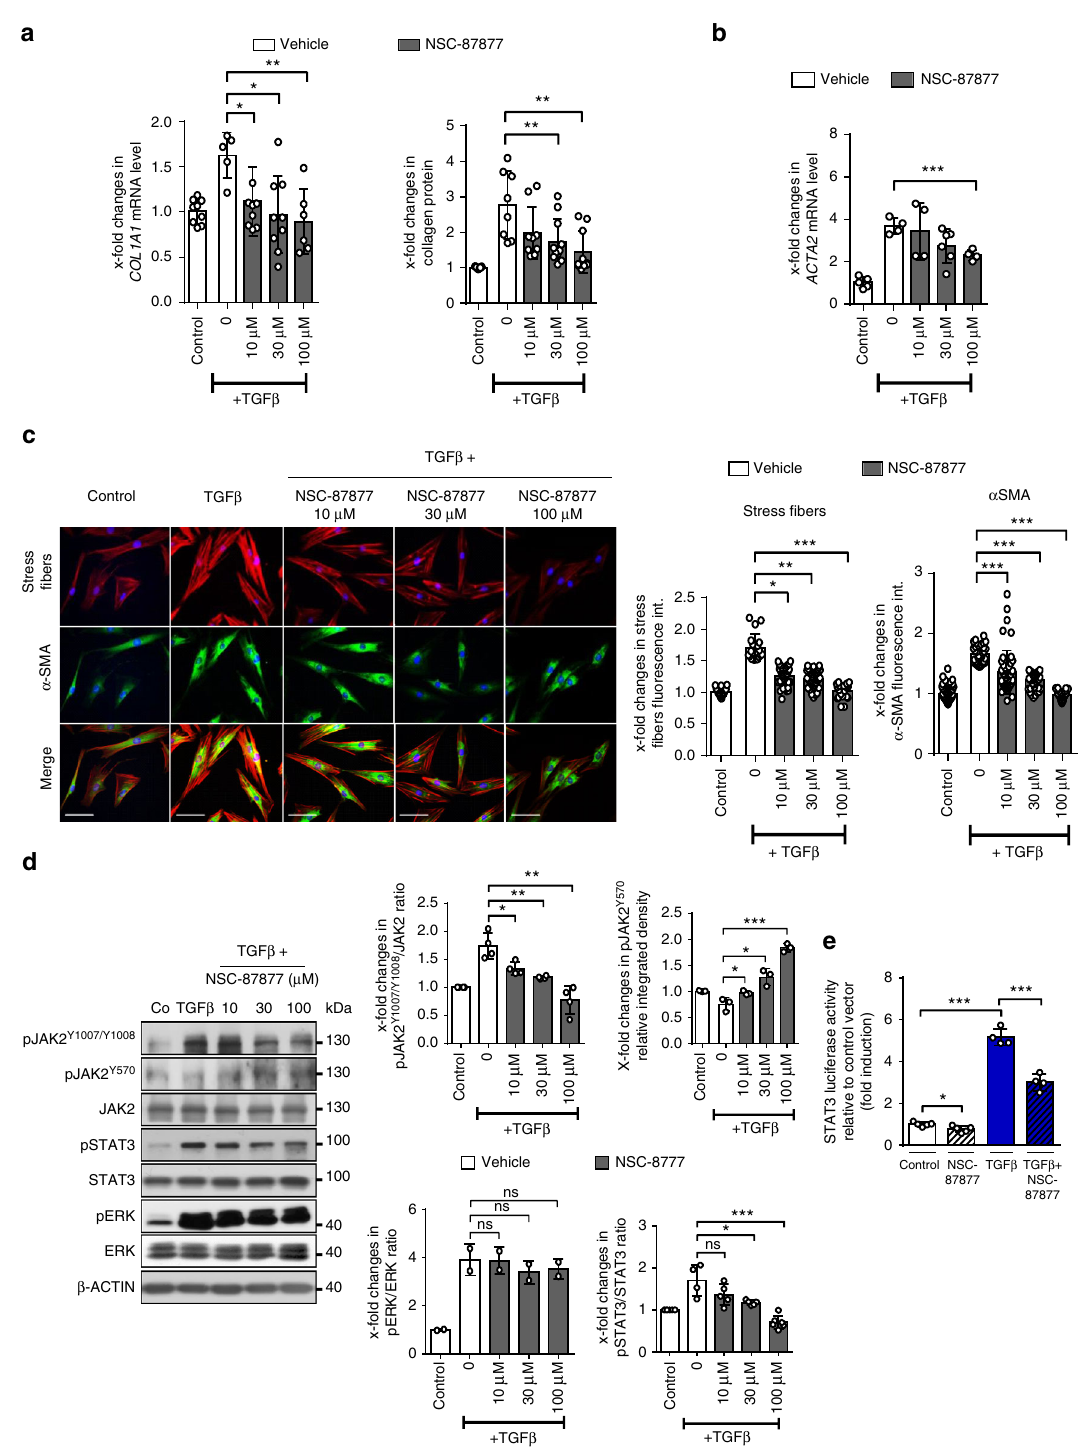
Fig. 8 Inhibition of SHP2 limits JAK2/STAT3 signaling and fi broblast activation. a Changes in the mRNA levels of COL1A1 and of collagen protein in human fi broblasts incubated with increasing doses of NSC-87877 (10 µ M, 30 µ M and 100 µ M). Fibroblasts were treated with TGF β (10 ng/ml) for 24 h. b ACTA2 mRNA. ( n ≥ 4) c Representative images of immuno fl uorescence stainings for α -SMA and stress fi ber staining are shown at 400-fold magni fi cation and quanti fi cation of α -SMA staining intensity as well as stress fi ber staining intensity ( n ≥ 15) (TGF β 10 ng/ml for 24 h). Horizontal scale bar, 500 μ m. d Representative western blots for pJAK2 Y1007/Y1008 , pJAK2 Y570 , total JAK2, pSTAT3 Y705 and total STAT3 with β -actin as loading control and quanti fi cation of the results (TGF β 10 ng/ml for 6 h) ( n ≥ 2). e Changes in STAT3 reporter activity ( n ≥ 6) (TGF β 10 ng/ml for 6 h). Results shown are representative of three independent experiments All data are presented as median ± s.e.m. The p values are expressed as follows: 0.05 > p > 0.01*; 0.01 > p > 0.001**; p < 0.001***; ns: not signi fi cant. Signi fi cance was determined by Mann – Whitney test. NSC-87877: SHP1/SHP2 inhibitor, Co: control unstimulated, int.: